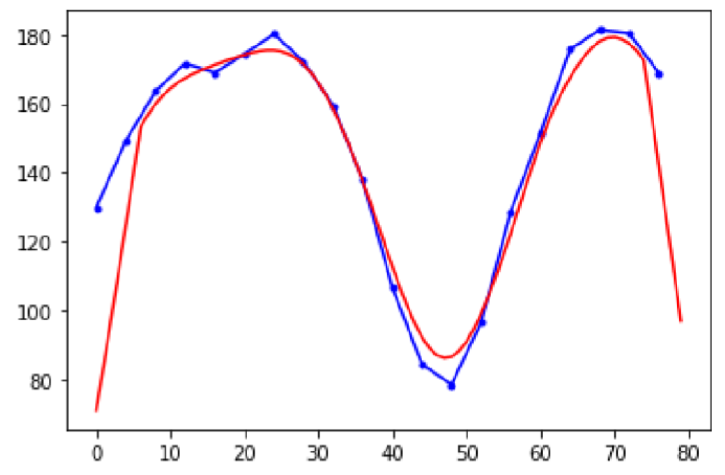
Figure 7. An example of data smoothing using discrete linear